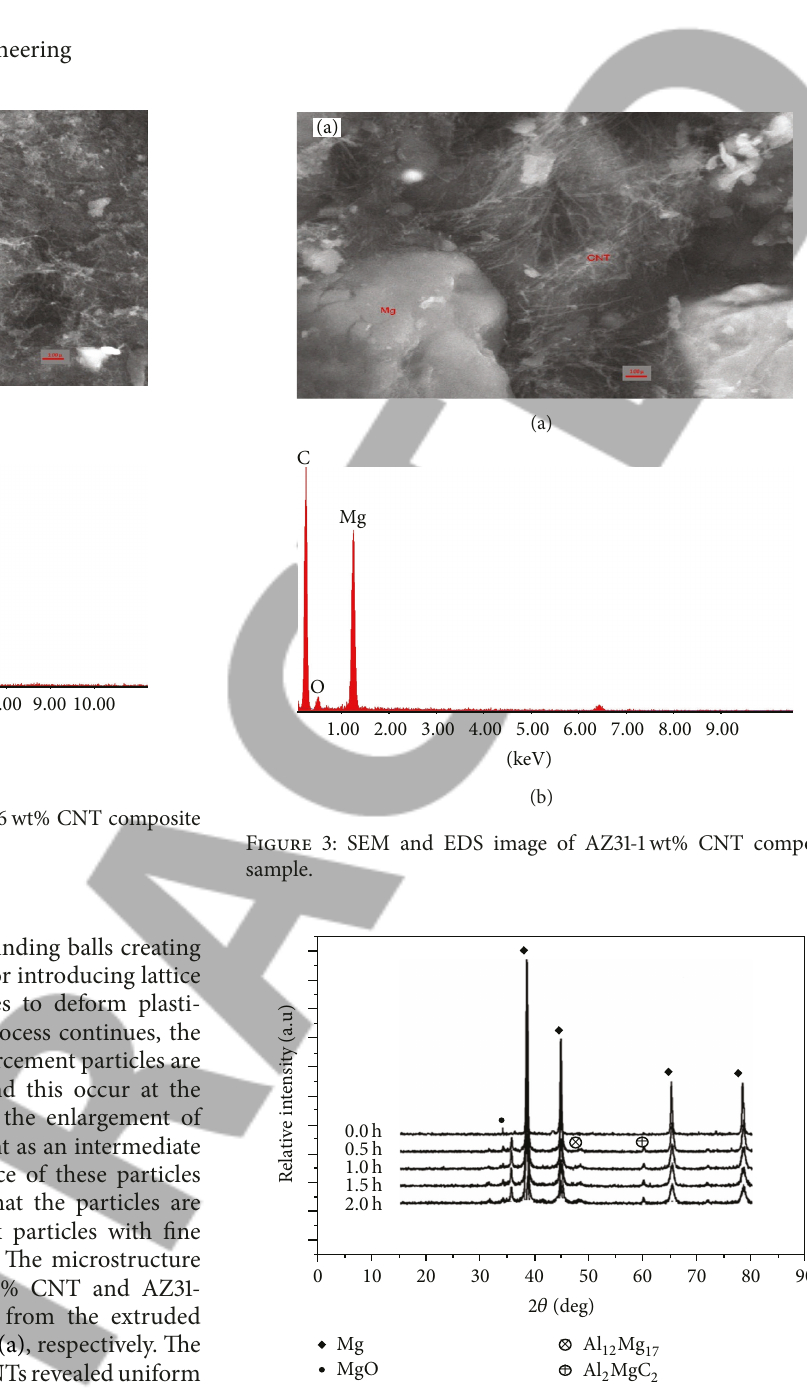
Figure 4: XRD profiles of AZ31-0.66 wt% CNT ball milled